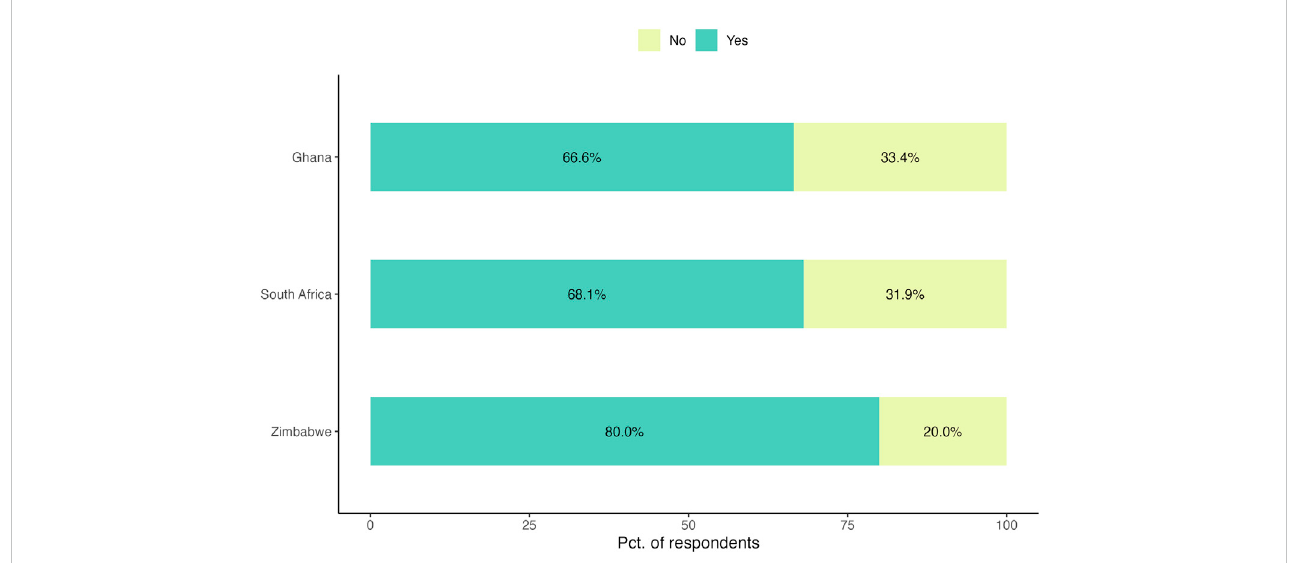
FIGURE 2 ‘ Did anyone tell you that you should take care of the soil? ’ question B4 from the ABC of Soil survey — yes or no. Taken from Johnson et al